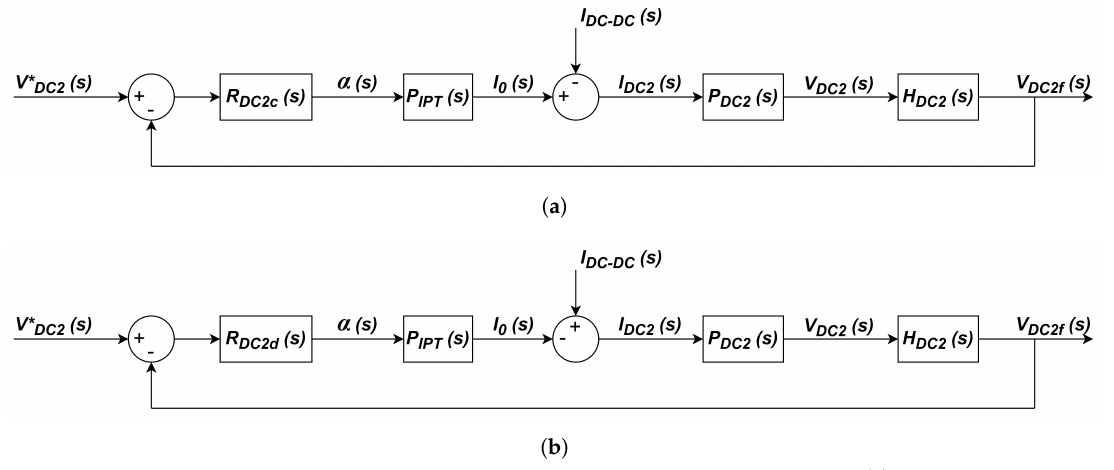
Figure 8. Block diagrams of the control subsystem for regulating the DC voltage V DC 2 ( s ) . ( a ) control system for the G2V operation mode; ( b ) control system for the V2G operation